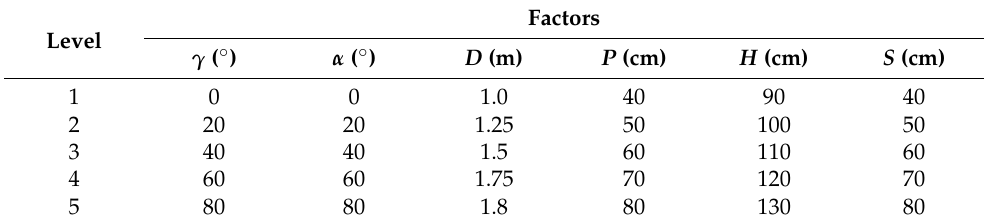
Table 6. The influencing factors and level of the layered structure rock mass.